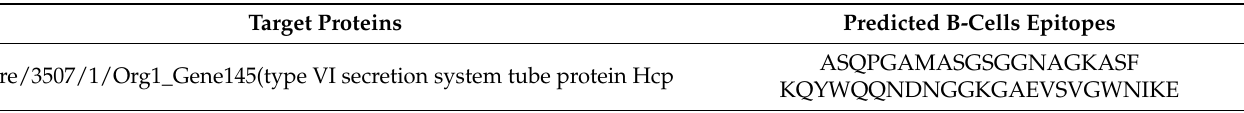
Table 1. Predicted B-cells epitopes.